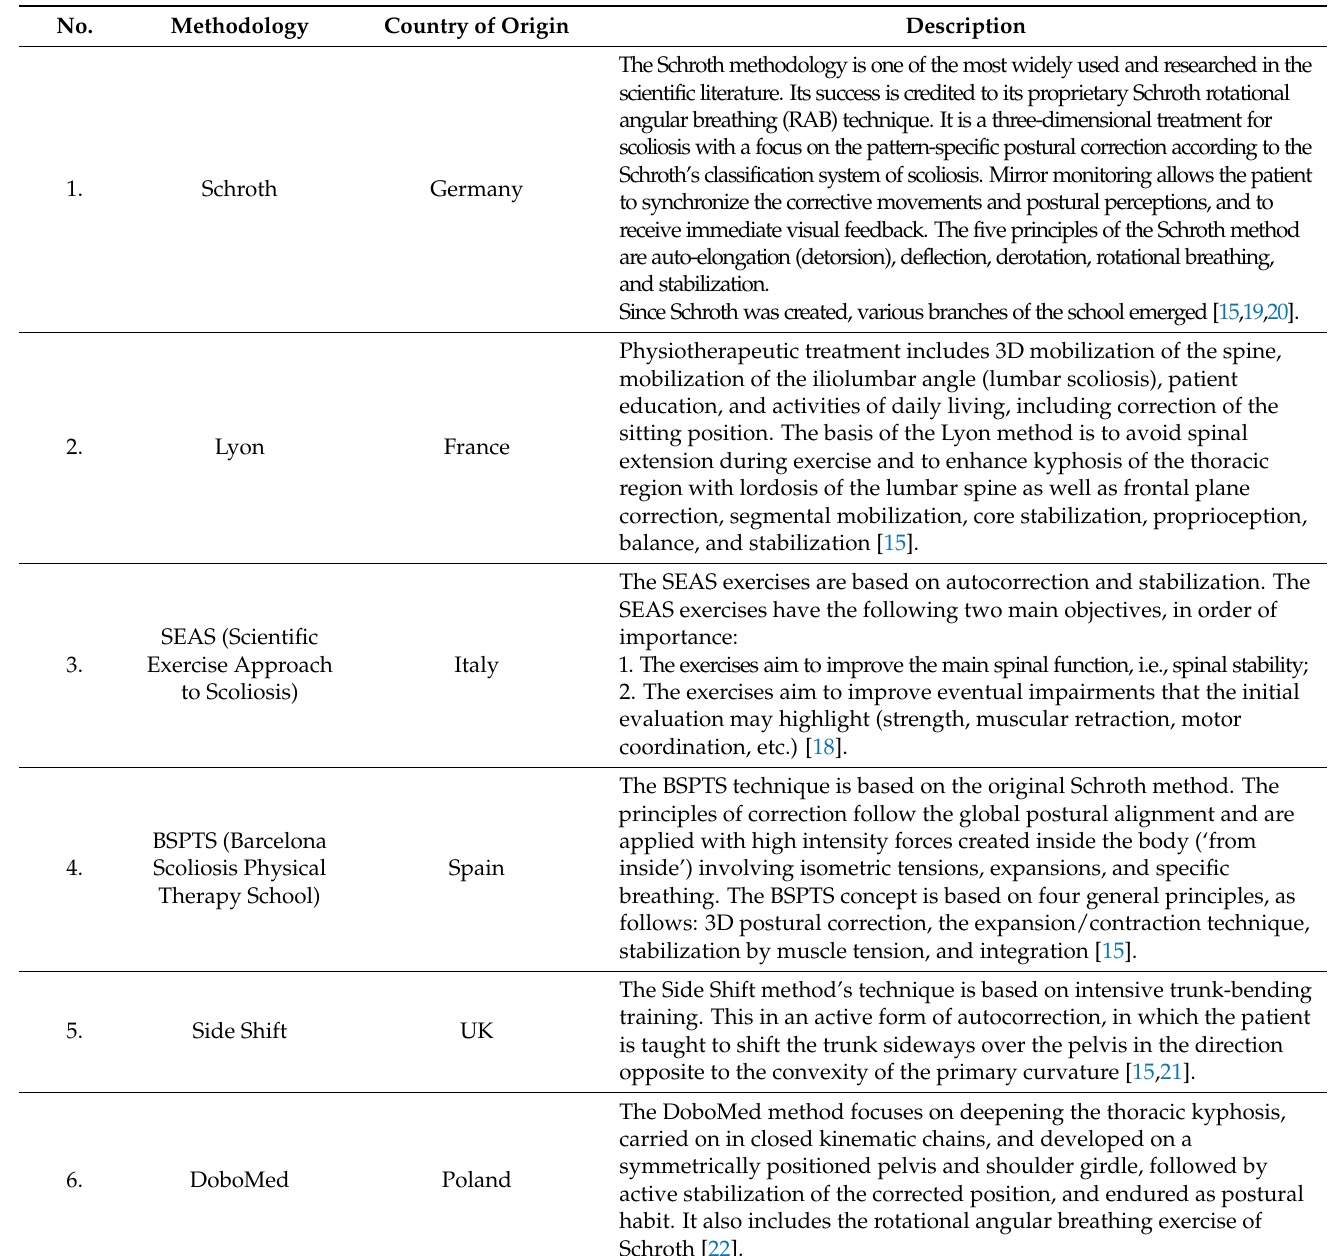
Table 1. Physiotherapeutic scoliosis-specific exercises (PSSE)